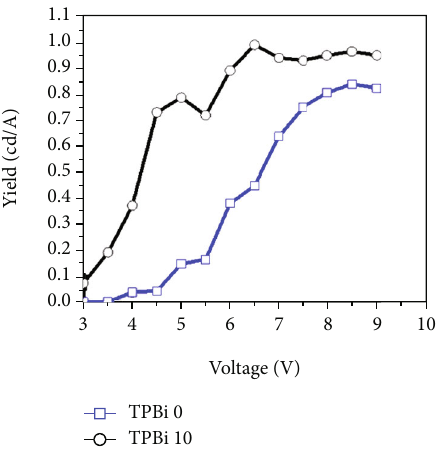
Figure 12: Current e ffi ciency-voltage characteristic curves of TE- OLED with electron transport/hole blocking layer 3 . 3